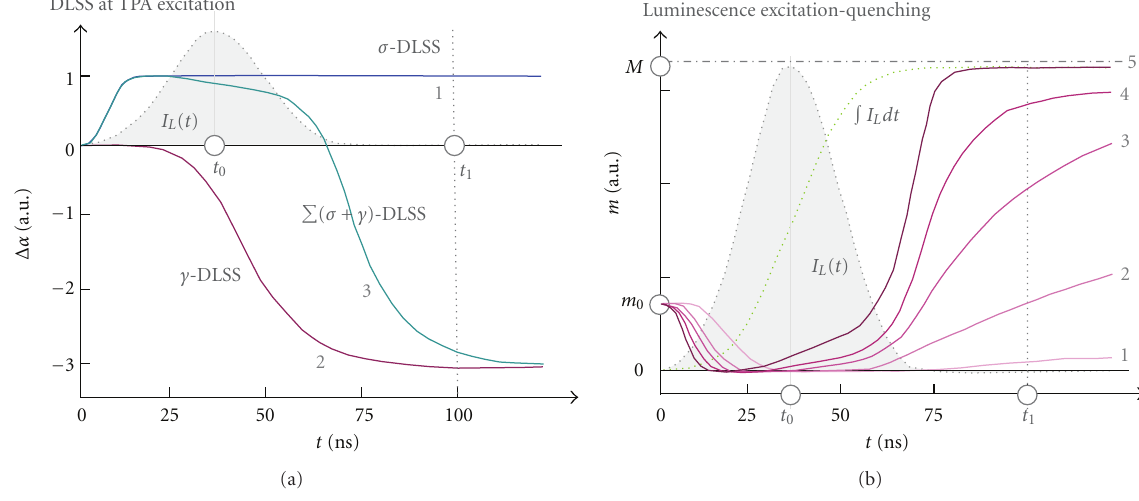
Figure 13: Calculation results for a kinetic of DLSS signals (a) and of the centers population (b) by (33) (or PL by (35)) at the two-photon excitation. (a) 1 and 2: Δ α ( t ) for the independently proceeding processes of σ - and γ -DLSS, accordingly; 3: induced absorption kinetics at joint action of σ - and γ -DLSS. (b) A kinetic of centers population m ( t ) at the di ff erent intensities of modulation: I L = 1; 3; 6; 10; 18MW/cm 2 for curves 1–5, accordingly. M : concentration, m 0 : initial population of DL. Dotted line: envelope of a modulation pulse (19). Parameters of CdS are used [24, 29]: M / m 0 = 4; γ cA = 10 − 9 cm 3 /s; σ vA ( ω L ) = 10 − 16 cm 2 ; β = 0,02 cm/MW; Δ t L =